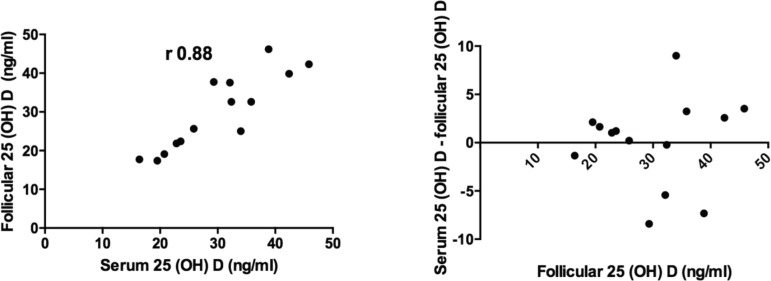
Follicular and Serum 25(OH) levels of 14 patients. Pearson’s correlation
coefficient and Bland-Altman plots.